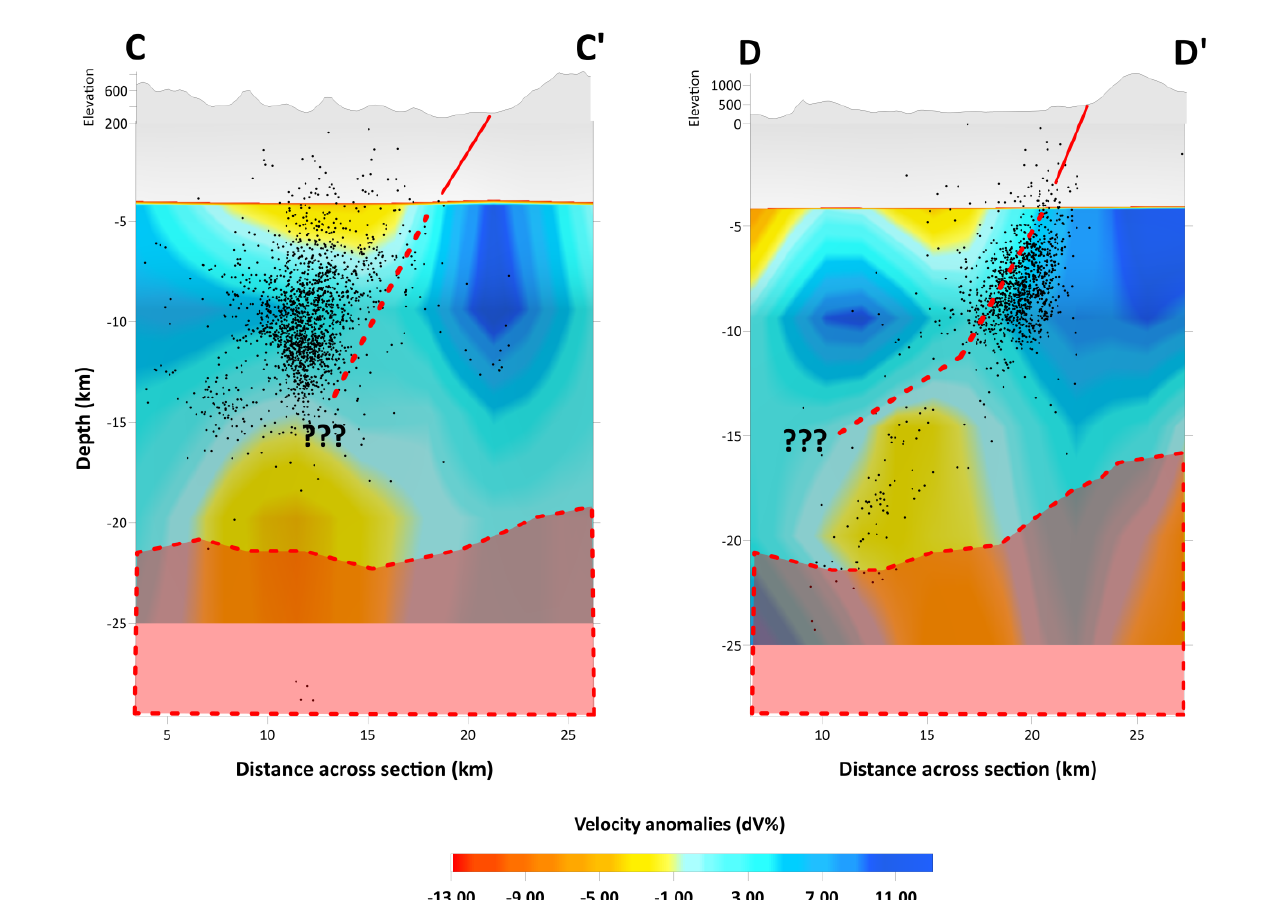
Figure 9. Cross-sections of vs. (%) perturbations. The cross-section traces are the same with the first four ones of Figure 5. four ones of Figure